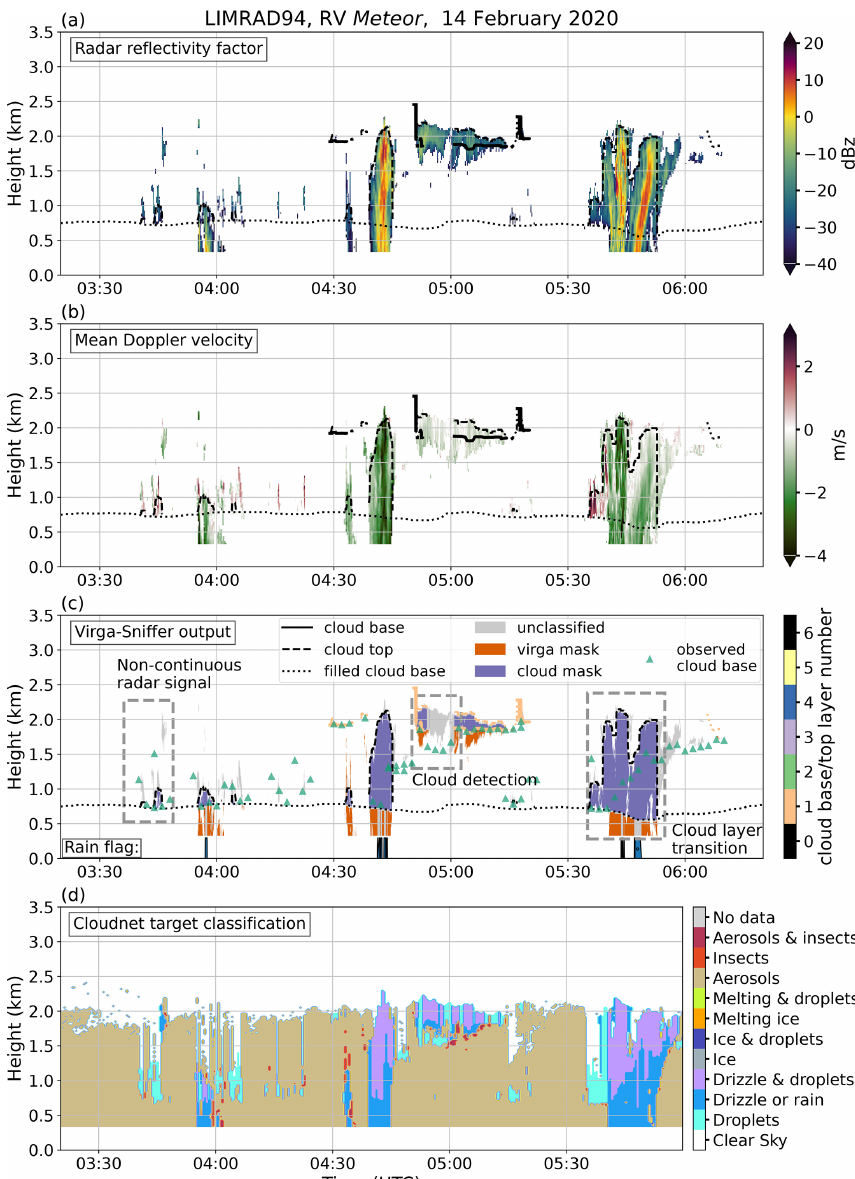
Figure 5. (a) LIMRAD94 reflectivity factor, (b) mean Doppler velocity, (c) Virga-Sniffer output, and (d) CloudNet target classification for 14 February 2020 as observed from RV Meteor . The Virga-Sniffer output is marked (dashed boxes) to reveal some caveats which include non-continuous radar signals (03:45UTC), cloud detection (05:00UTC), and multilayer cloud transition (05:45UTC). For comparison, the observed CBH from the ceilometer is shown in panel (c) . The color bar denotes the number of cloud layers detected on that day (count starts at zero for the lowest